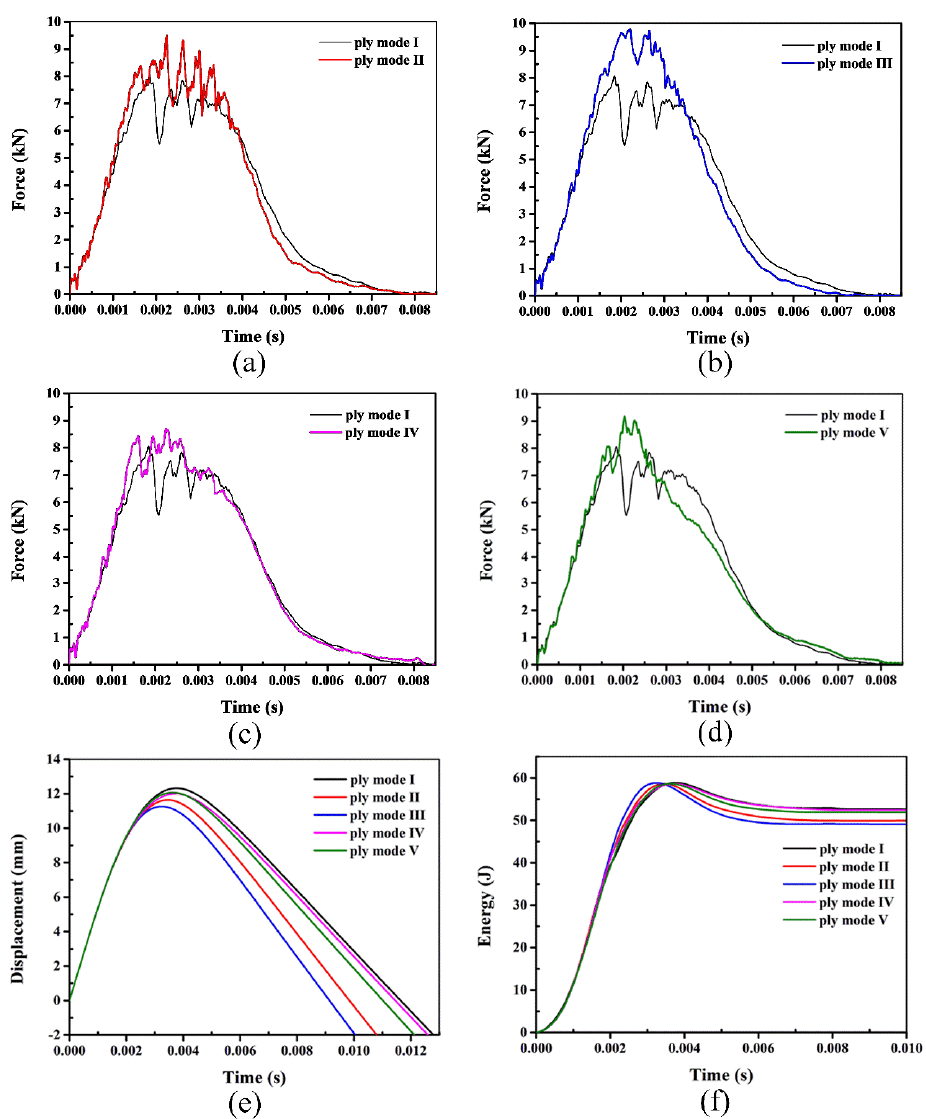
Figure 10. Typical impact behavior of laminates with 60 J (Figures ( a – d ) show the force-time curves of mode I with mode II, mode III, mode IV and mode V, respectively. Figure ( e ) and Figure ( f ) represent the displacement-time and energy-time histories of different modes, respectively).